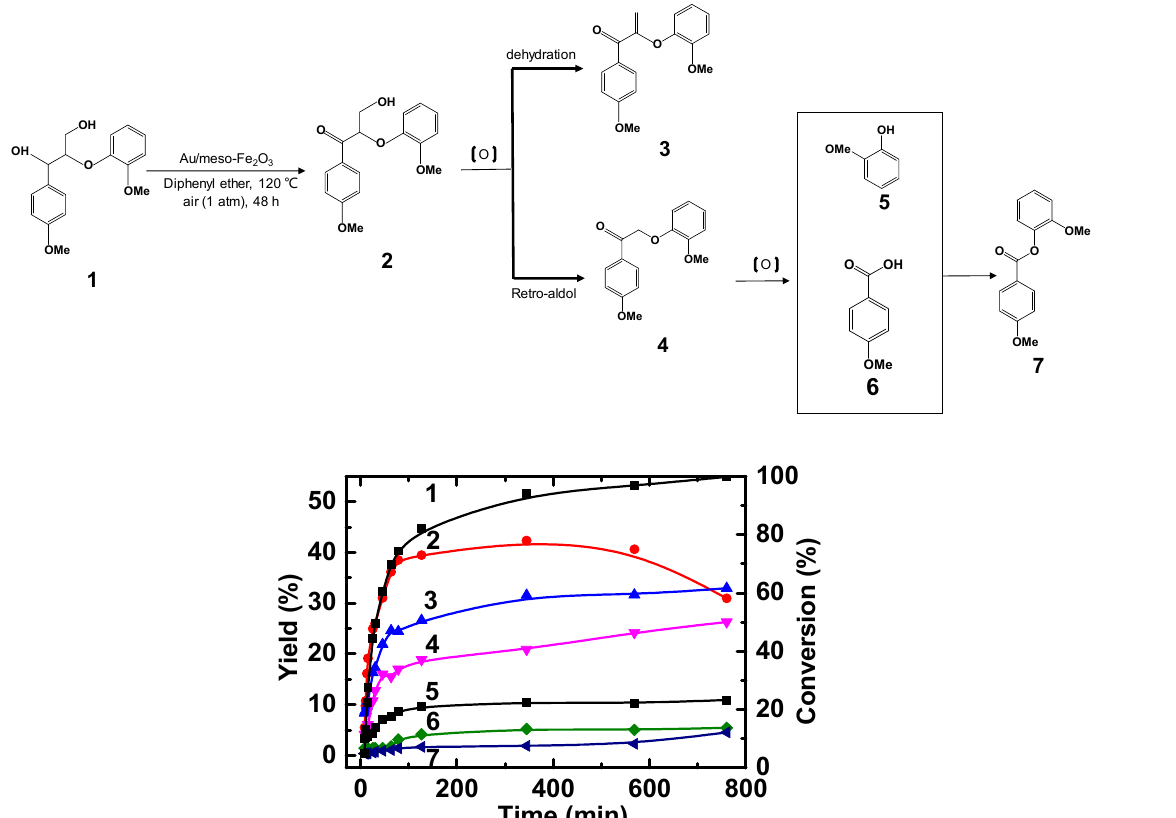
Figure 3. The aerobic oxidation of the lignin model dimer using Au / meso-Fe 2 O 3 . Conditions: substrate (1 mmol), catalyst (100 mg), diphenyl ether (10 mL), 120 ◦ C, p = 1 atm. air (30 mL · min − 1 ). The conversion and yields were determined by GC-MS using dodecane as the internal standard.